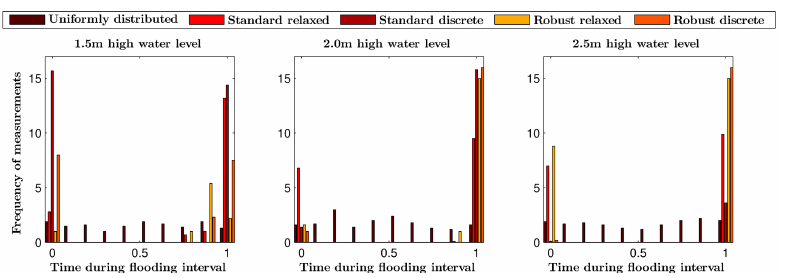
Figure 3. Averaged efficiency for the experimental designs from 10 optimization runs with the C 2 -model and three measurement per iteration with standard deviation 10 − 2 of the measurement error.